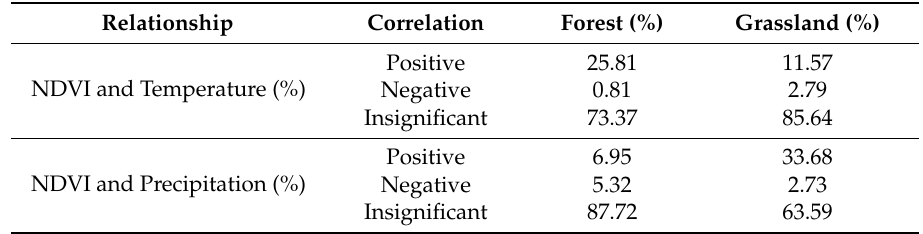
Table 3. Partial correlation coefficients for the relationships between the NDVI and temperature (upper) and between the NDVI and precipitation (lower) in different vegetation